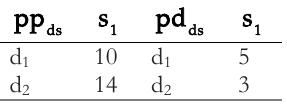
Table 3. The number of earthquake victims and corpses in need of evacuation in each